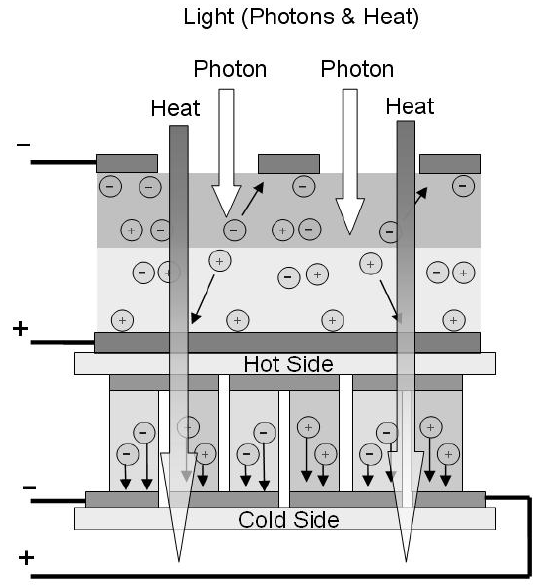
Figure 13. Hybrid Solar PV/thermoelectric